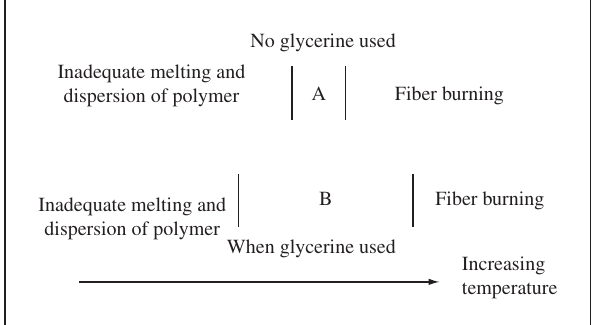
Figure 1. Schematic of processing window of fibers with and without glycer- ine: A) When no glycerine used, the processing window use is very narrow; and B) When glycerine was used it expanded the processing